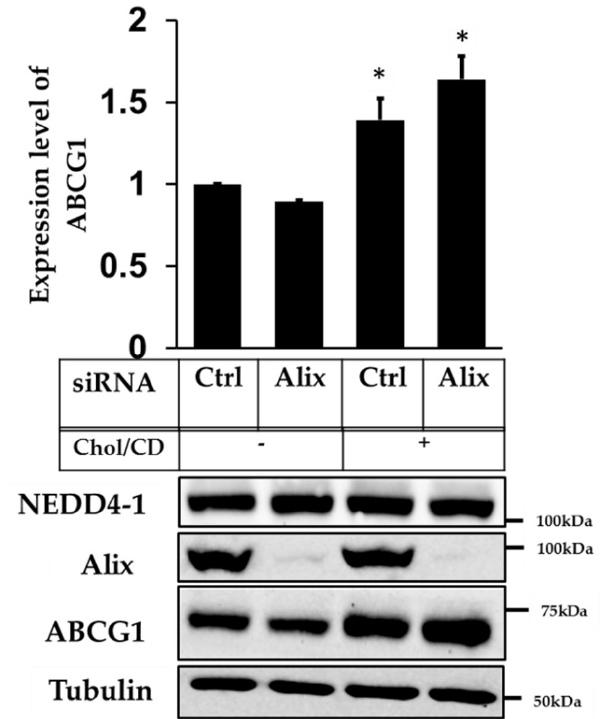
Figure 3. Effect of Apoptosis-linked gene 2-interacting protein X (Alix) knockdown on ABCG1 protein expression in ABCG1-CHOK1, with and without cholesterol loading. Representative immunoblot of ABCG1-CHOK1, transfected with either control or Alix siRNA, and treated for 6 h with or without Chol/CD (20 µg/mL) in 0.1% BSA. Mean ± SEM of 3 individual data points from two independent experiments, expressed as fold change relative to control without chol/CD. * indicates p < 0.05 compared to control.